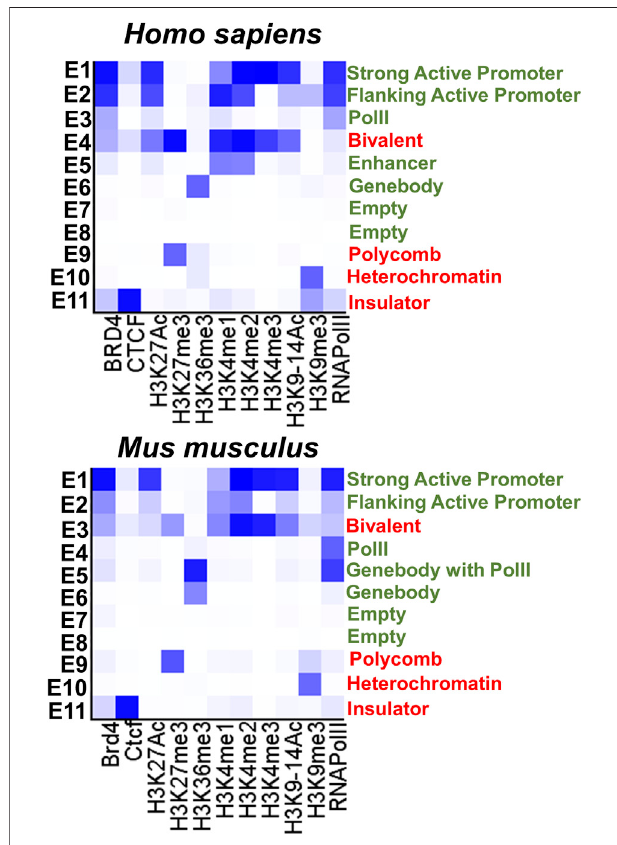
FIGURE 1 | The eleven chromatin states (permissive states are marked in green, repressive states are marked in red) were identi fi ed with the chromHMM software package using human and mouse retinal ChIP-seq data. The darker blue color in the heat maps labels abundant ChIP-seq marks in the chromatin